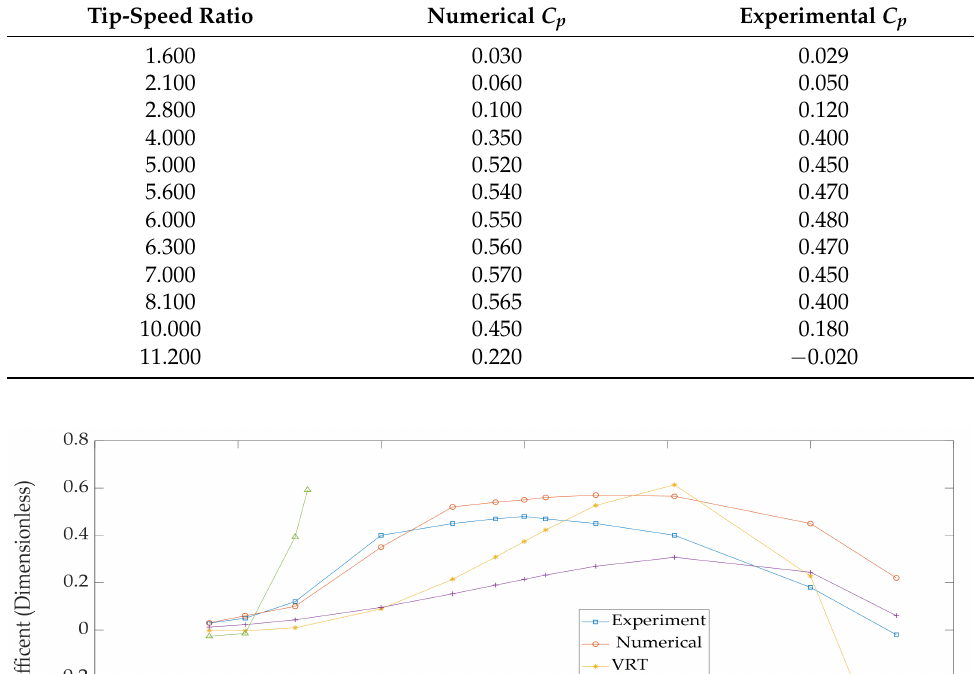
Table 2. Existing values of the power coefficient (adopted from Reference [28]).